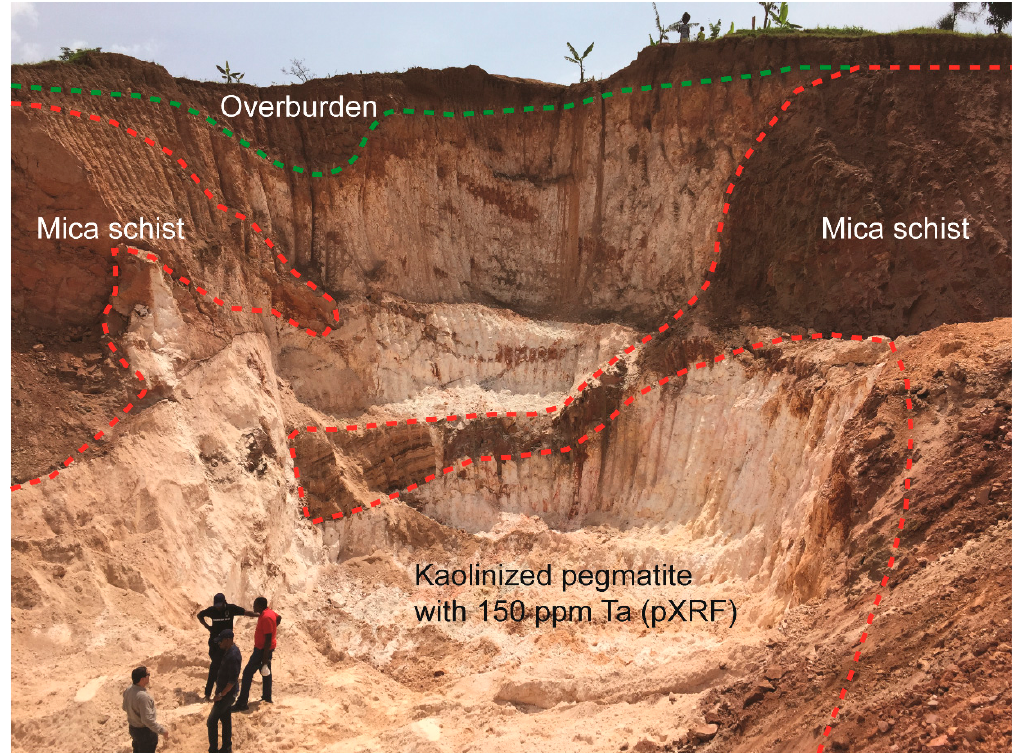
Figure 1. Typical exposure of Li–Cs–Ta (LCT) pegmatite in the Ruhanga area, Rwanda. This pegmatite is currently (in 2018) exploited for columbite-tantalite mineralisation. The pegmatite body is 15–20 m wide and has a lateral extension of at least 2.5 km. Complete kaolinisation of feldspars, resulting in an unzoned appearance, characterise most Rwandan pegmatites. This creates issues with slope stability [45], but allows simple artisanal open-cast excavation of the orebody to a depth of 30 m. Note the rafts of biotite schist in the weathered pegmatite illustrating the assimilation of country rock material, which can have a detrimental influence on ore grade and dilution, and therefore needs to be appropriately modelled.